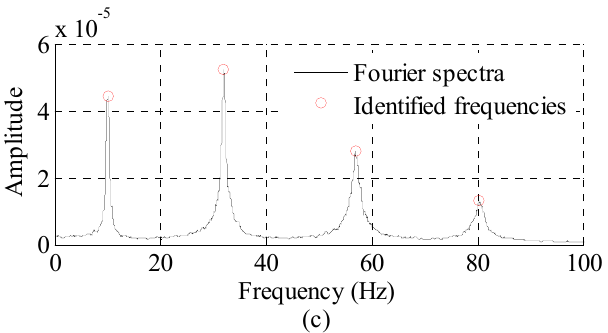
Figure 4. Strain gauge measurement data and Fourier spectra of the data. ( a ) Strain gauge measurement data (0–60 s); and ( b ) concentrated on 4–6 s for clear presentation; and ( c ) Fourier spectra of the measurement data (0–60 s).